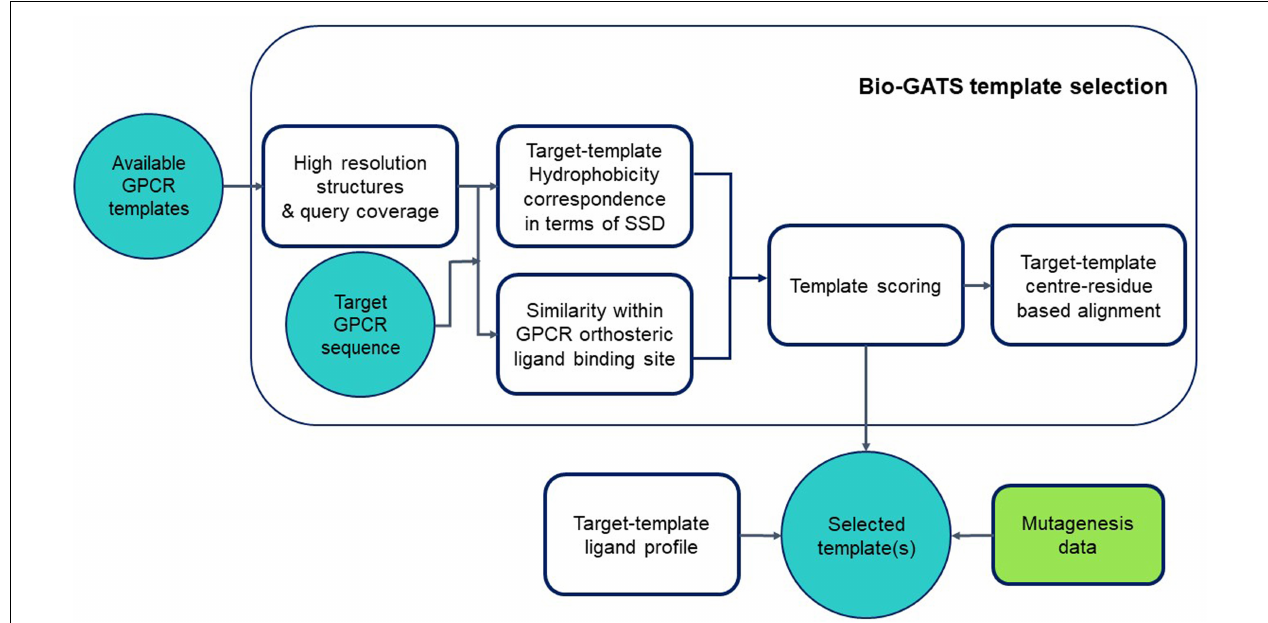
FIGURE 1 | Workflow for GPCR template selection through a biophysical approach, with details of how templates are selected and the alignment is